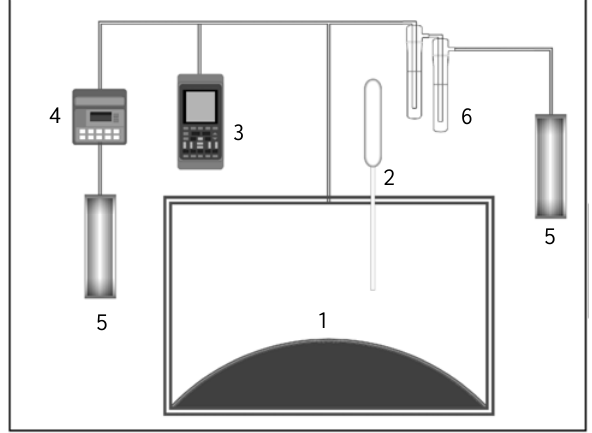
Fig. 1. Scheme of the sludge composting facility: 1 – sludge composting equipment with materials being com- posted; 2 – thermometer; 3 – gas meter; 4 – gas meter GD/MG7; 5 – air pump; 6 – Zaitsev